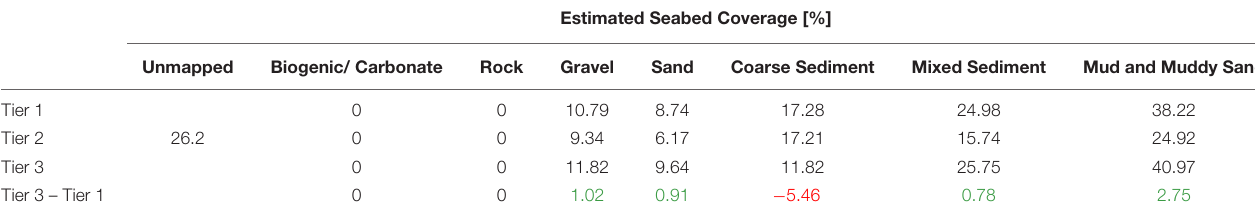
FIGURE 4 | Sediment type mapped across the Loch Linnhe fjord complex. (A) Loch Linnhe in context of the United Kingdom, (B) Tier 1, point observations, (C) Tier 2, backscatter, (D) Tier 3 Composite approaches, and (E) Confidence map produced from the Kriging Standard Error. TABLE 1 | Difference in seabed coverage (%) for each of modified Folk classes (Kaskela et al., 2019) across the Loch Linnhe fjord complex calculated using the different mapping techniques, Green indicates that the Tier 1 map underestimates seabed coverage while Red is indicative of an overestimation in comparison to the Tier 3